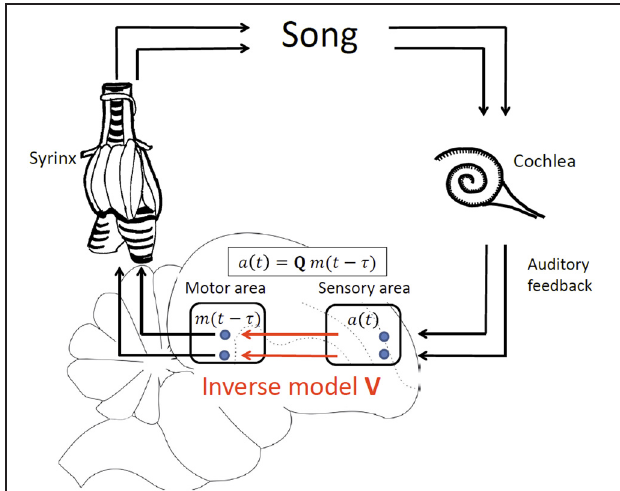
FIGURE 2 | Delayed feedback and inverse model, illustrated by vocal production in birds. In our model of delayed sensory feedback the auditory response a ( t ) in a sensory area at time t depends linearly on motor activity m ( t − τ) in a motor brain area at an earlier time t − τ according to a ( t ) = Q m ( t − τ) , where Q is the unknown motor-sensory mapping and τ the unknown delay of auditory feedback. An inverse V is a mapping from sensory neurons back onto motor neurons that inverts the action of Q : V = Q − 1